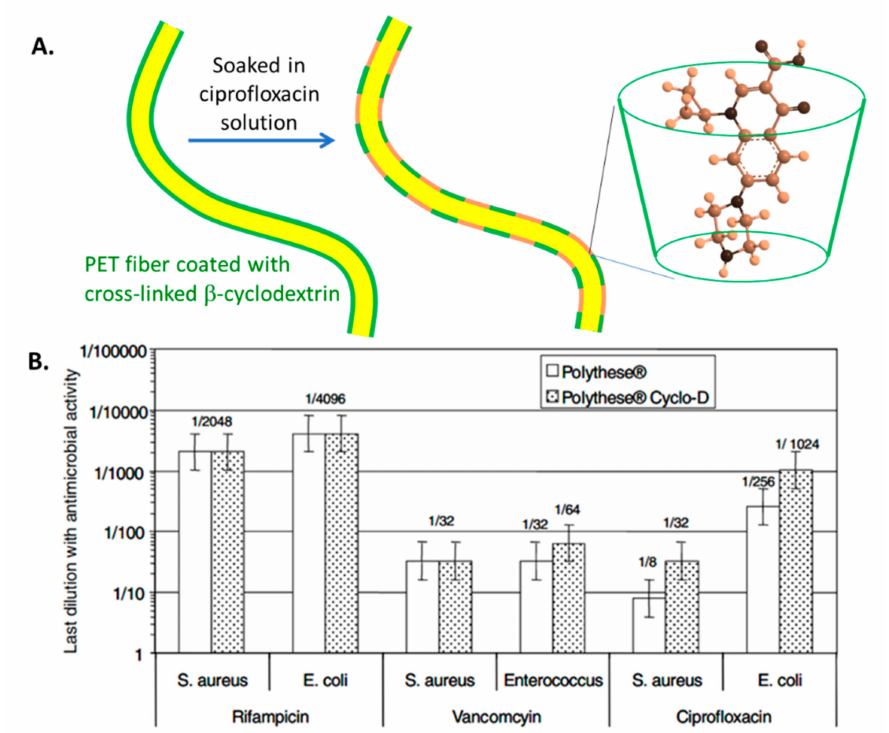
Figure 3. Use of cyclodextrin polymer to encapsulate antibiotics. ( A ) Schematic of polyester prosthe- ses coated with a cyclodextrin polymer and activated with ciprofloxacin. ( B ) Antimicrobial activity of polyester prostheses activated with antibiotics, with and without cyclodextrin. Reprinted with permission from [103] Copyright